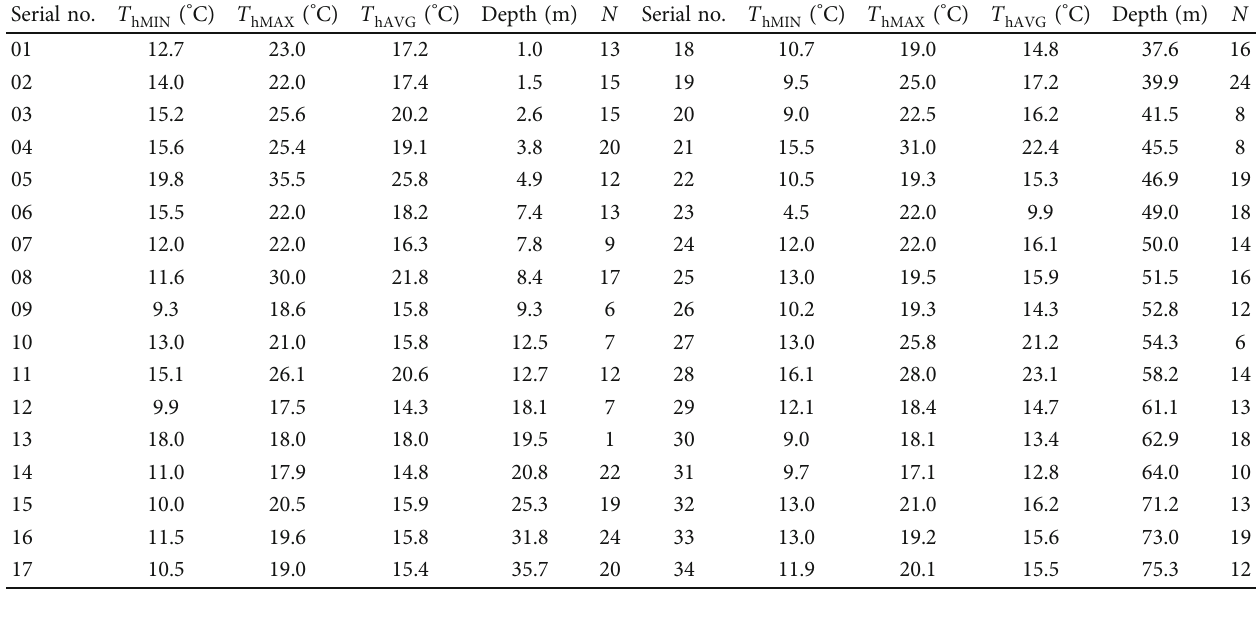
Table 2: The samples without temperature data and K and